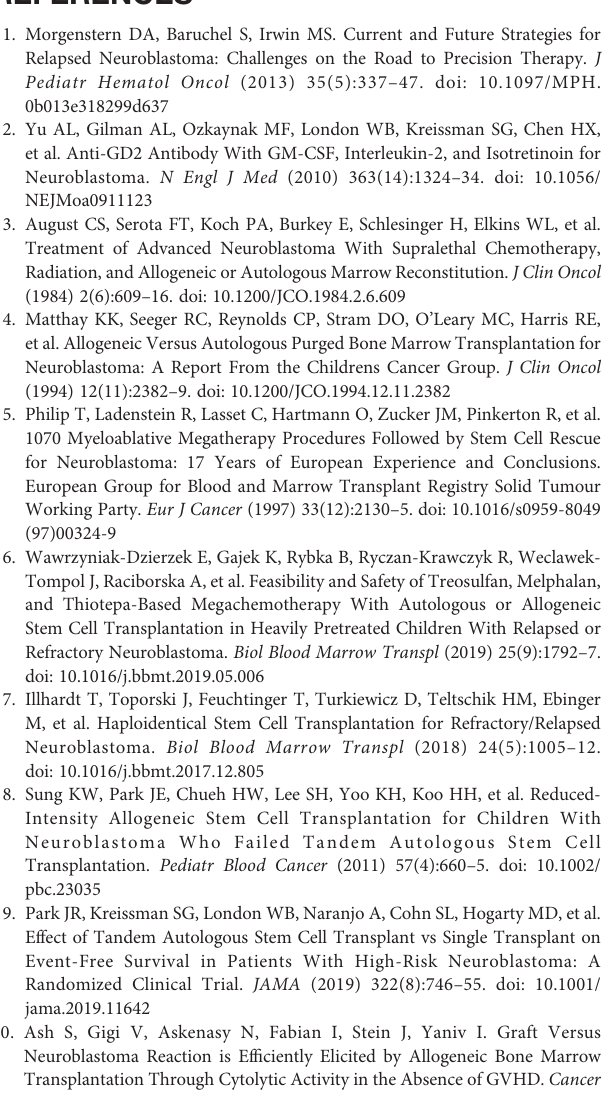
Supplementary Figure 4 | Cytokine production pre- and post-adoptive transfer of ex vivo activated NK cells. B6AJF1 mice were lethally irradiated on Day +0 and transplanted with 5 x10 6 B6 BM cells and 1 x10 6 B6 T cells on Day +0. Serum was collected as a baseline cytokine measurement. On Day +10, mice were inoculated with 2 x10 6 NXS2 neuroblastoma cells. On Day +14, mice wereinfused with PBS or 2.5 x 10 6 B6 CD137L/IL15/IL15R a activated NK cells. Serum was collected 1 (Day +21) and 2 weeks (Day +28) after infusion. Serum was batched and run in duplicate per timepoint for each group. N=5 mice/group. *p < 0.05, otherwise no signi fi cant differenceswere seen. Supplementary Figure 5 | Comparison of tumor in fi ltrating wild type and TNF a - de fi cientNKcellsafterallogeneicHSCTandICtreatmentforNBL.Lethallyirradiated A/J mice (H-2a) were transplanted with CD3e cell depleted B6 BM (H-2b) with 2.5 x 10 6 B6 T cells on Day +0. On Day +10, 2 x 10 6 NXS2 tumor cells were inoculated into the right fl ank. On Days +14-16, hu14.18-IL-2 (IC) was administered. On Day +16, select groups were infused with 2.5 x 10 6 CD137L/IL-15/IL-15R a expanded NK cells from B6 wild type (TNF a +/+) or B6 TNF a -/- donors. Both spleens and tumors were harvested at Day +30 and analyzed for T cells and NK cell subsets. N=3-5 mice/group. No signi fi cant differences were